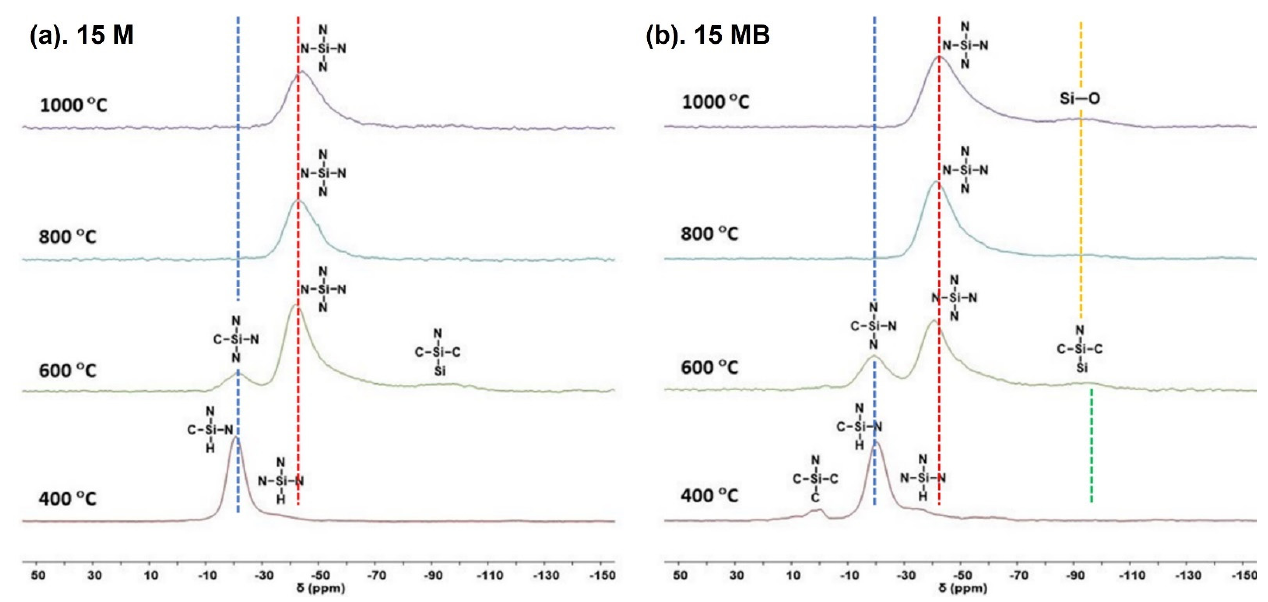
Figure 6. The 29 Si-NMR spectra of the pyrolysis products of ( a )15 M and ( b )15 MB at different tem- peratures.